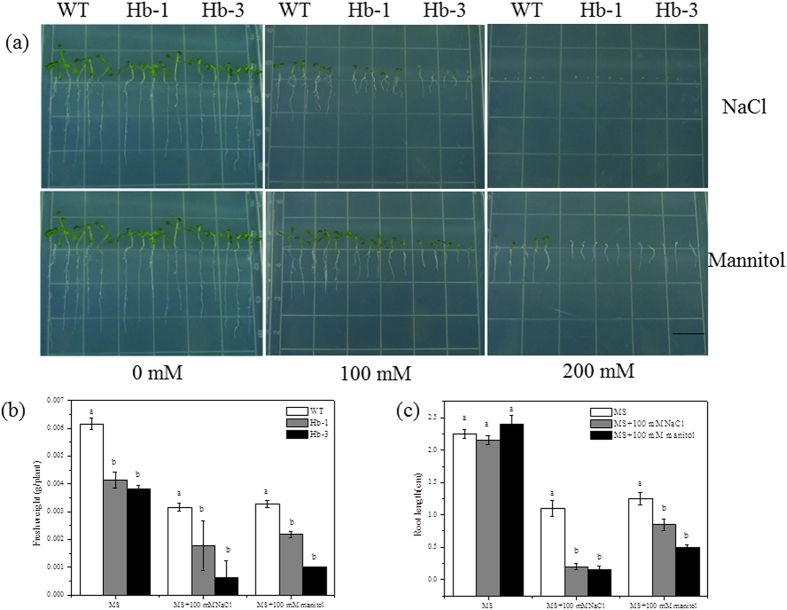
Effect of NaCl and osmotic stress on the growth of SoHb transgenic Arabidopsis for 7 days.Seedling morphology (a), root length (b), fresh weight (c) of the WT and transgenic lines grown on MS supplemented with 0, 100, and 200 mM NaCl and mannitol. WT was wild type Columbia Arabidopsis; Hb-1 and Hb-3 were two homozygous transgenic Arabidopsis lines. The experiment was replicated three times with similar results. Bars = 1 cm.